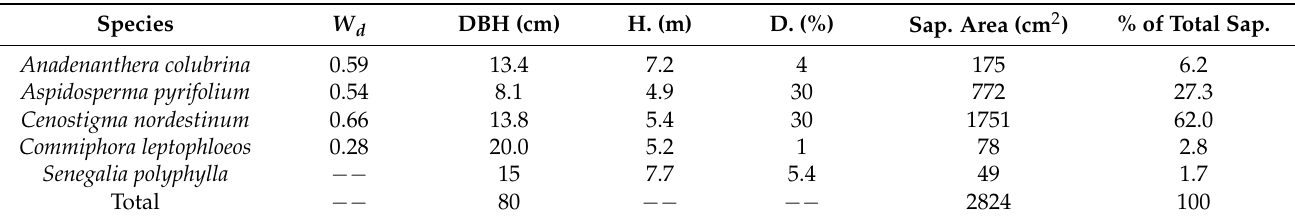
Table 1. Tree species monitored, wood density ( W d , g · cm − 3 ), mean diameter at breast height (DBH) mean species height (H.), dominance in the plot (D.), estimated sum of the sapwood area per species per species, percentage of the sapwood area in relation to the total sapwood area in the